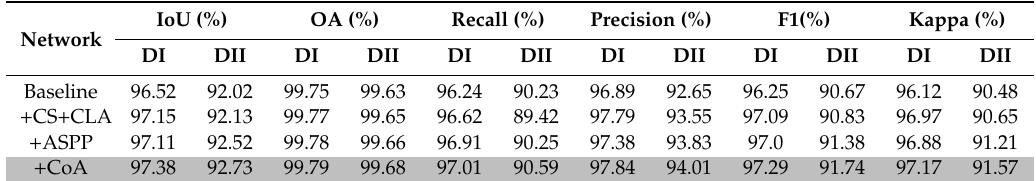
Table 2. Ablation experiments of the methods with di ff erent modules (the shadow represents the best results of the basic network with all the proposed